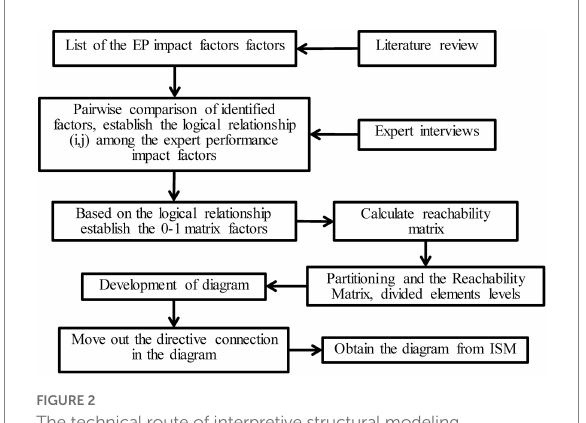
FIGURE 2 The technical route of interpretive structural